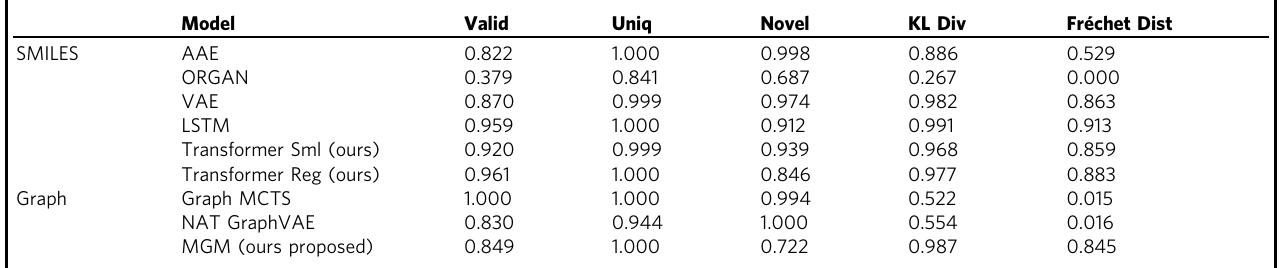
Table 4 Distributional results on ChEMBL. LSTM, Graph MCTS 52 , AAE 67 , ORGAN 62 and VAE 49 (with a bidirectional GRU 53 as encoder and autoregressive GRU 53 as decoder) results are taken from Brown et al. 46